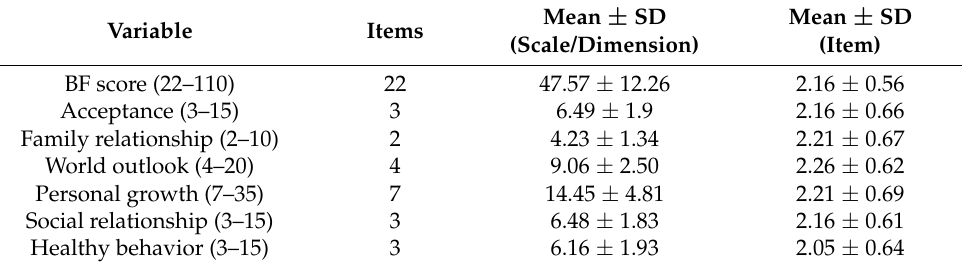
Table 1. The mean scores of BF and its six